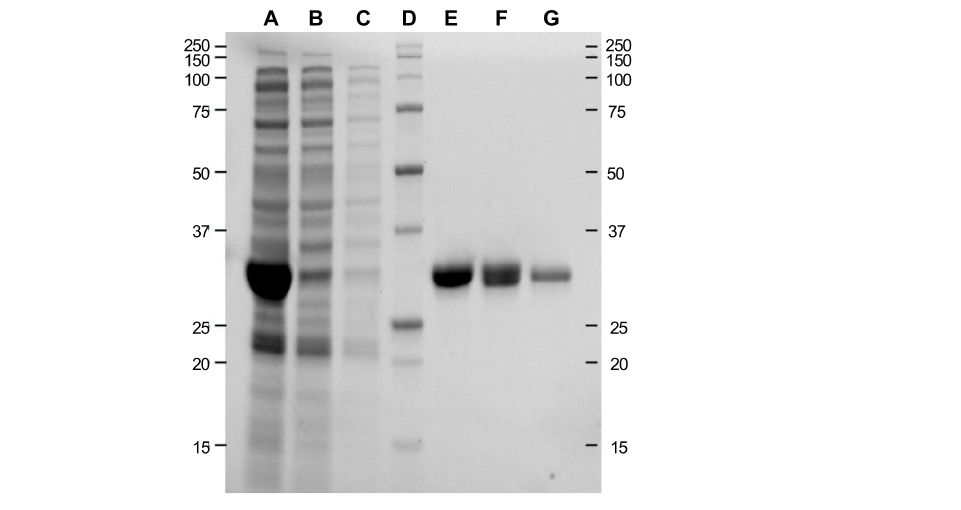
Figure 3. Denaturing condition gel electrophoresis analysis of TtEst2 chromatographic purification fractions. ( A ), crude soluble extract; ( B ), flow-through fraction of the initial metal chelate chromato- graphic step; ( C ), wash fraction of the initial metal chelate chromatographic step; ( D ), molecular weight standards (weights in kDa are reported on both sides of the gel); ( E ), elution fraction of the initial metal chelate chromatographic step; ( F ), dialysis fraction after TEV protease cleavage; ( G ), flow-through fraction of the second metal chelate chromatographic step.